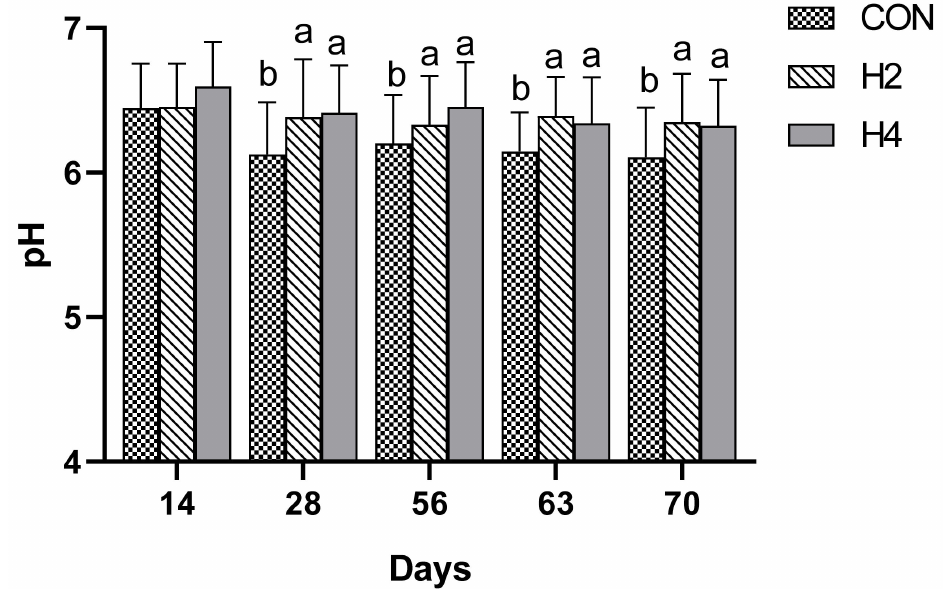
Figure 4. Ruminal pH for Holstein female calves fed a basis diet without (CON: checkered bar; n = 14) or with hay inclusion from the second (H2; stripe bar; n = 14) or fourth (H4; gray bar; n = 14) week of age. Different letters within a time point indicate significant differences between treatments ( p <